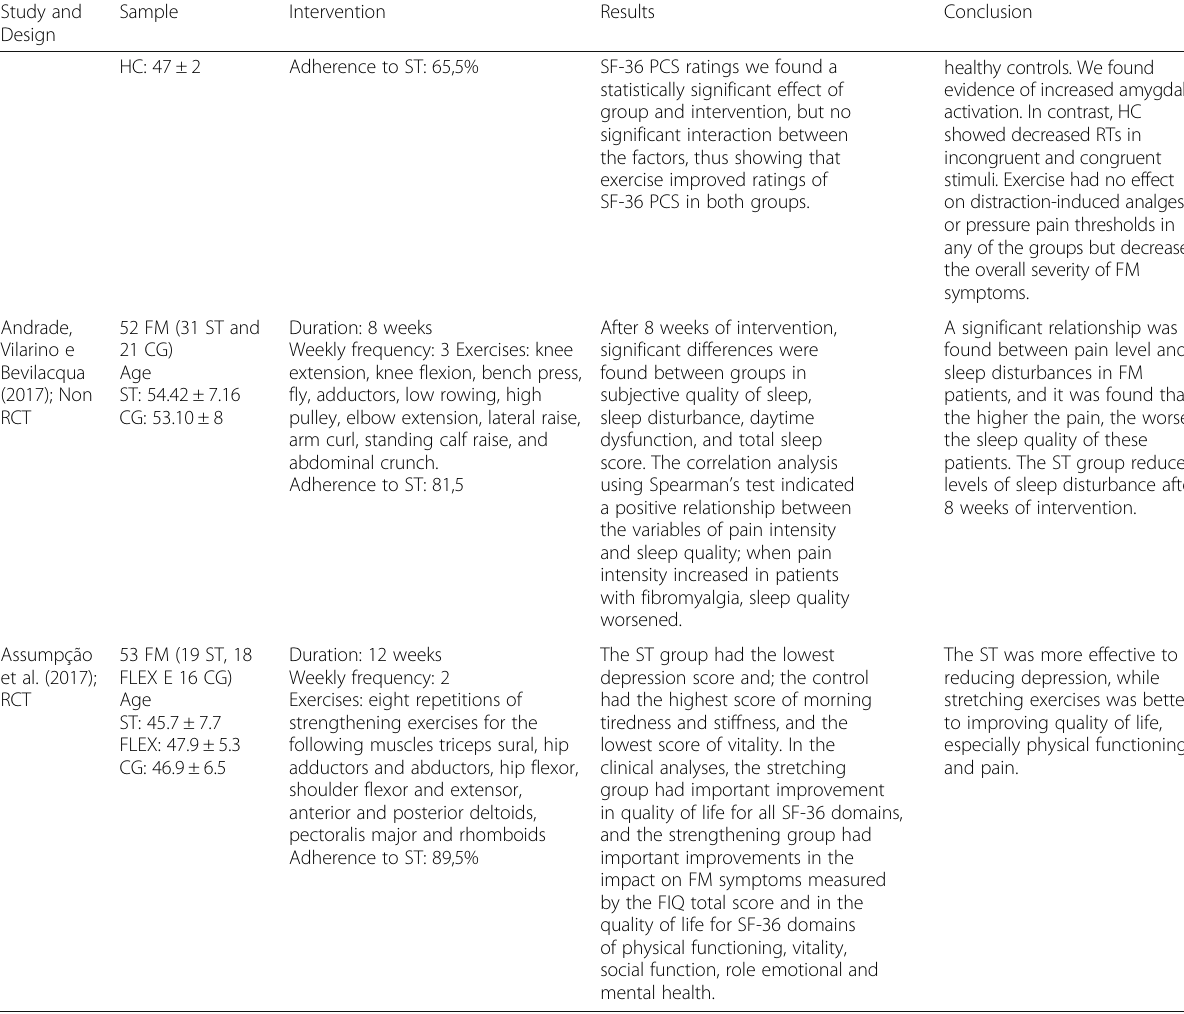
Table 2 Characteristics and results of experimental studies with strength training for patients with fibromyalgia syndrome